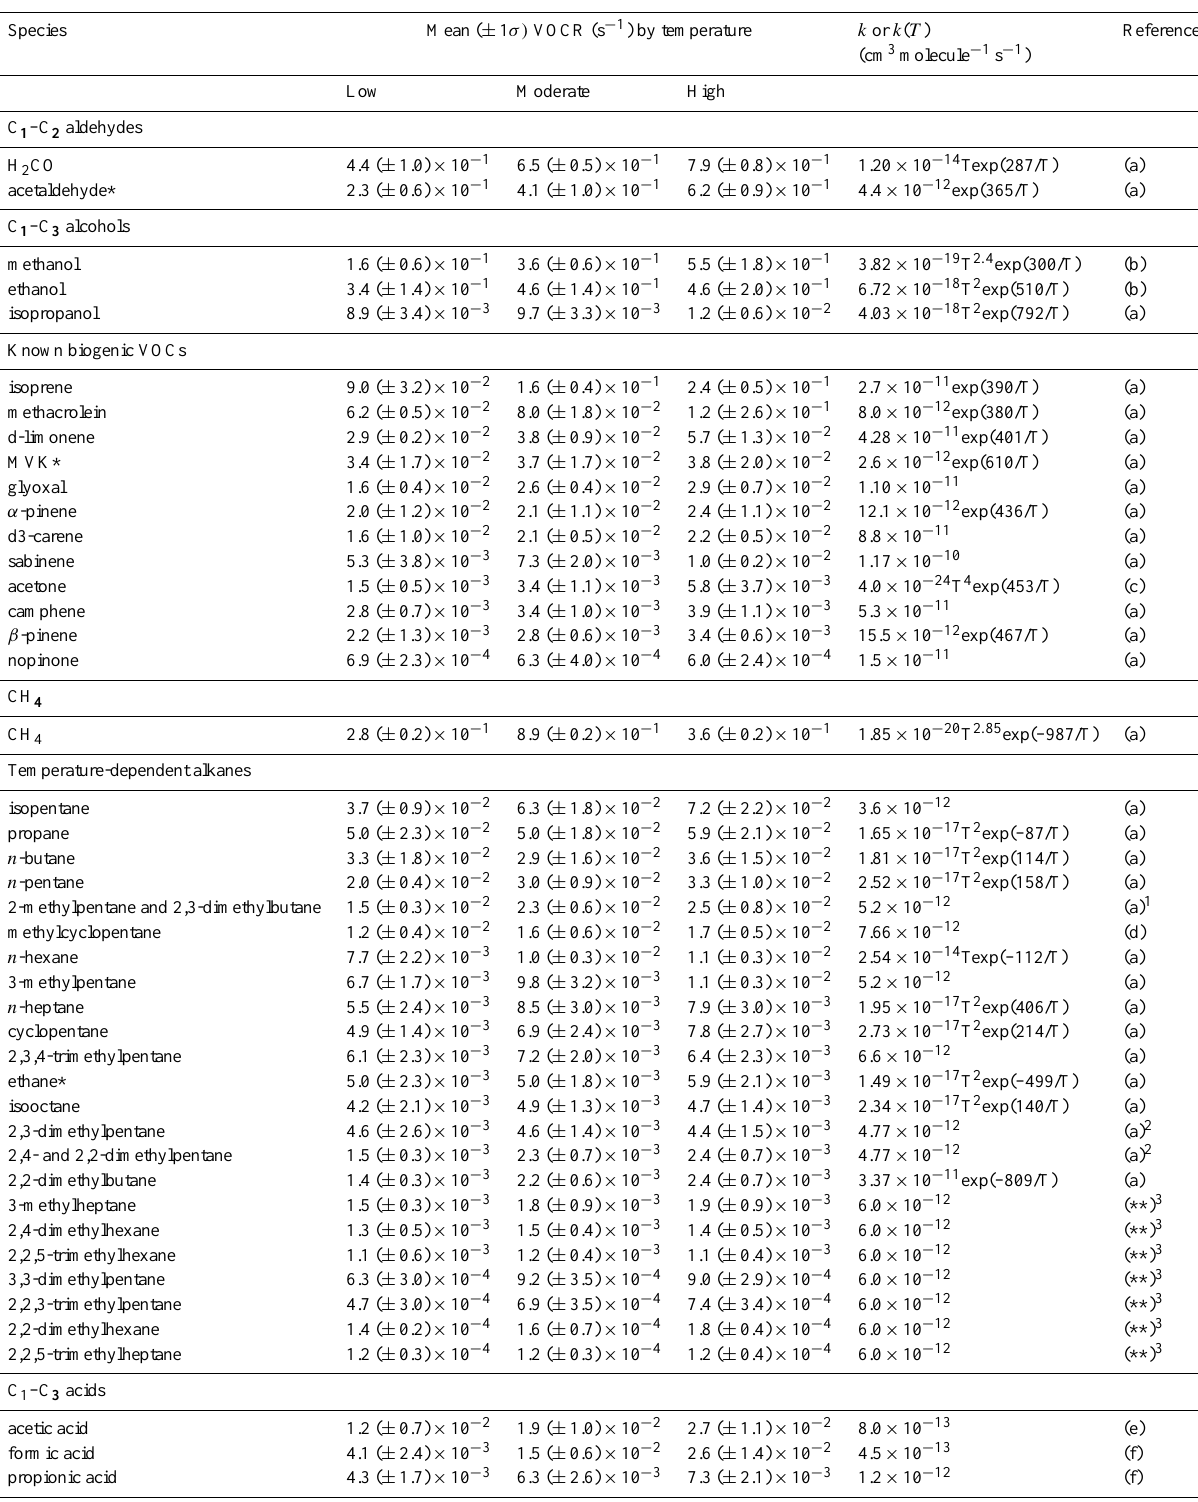
Table B2. Mean VOCR i of all species included in 6 i VOCR i ± 1 σ , indicating the observed variability, over low (17–27 ◦ C), moderate (28–33 ◦ C), and high (34–45 ◦ C) daily maximum temperatures. Species are arranged by Fig. 1 grouping and listed greatest to smallest high- temperature per second. The VOC i + OH rate constants or temperature-dependent rate expressions are also listed with associated references. The concentrations of the starred species, acetaldehyde, MVK, ethane, and benzene, were estimated (Appendix B). Double starred k OH values were estimated by analogy to compounds with similar molecular structure and these include explanatory